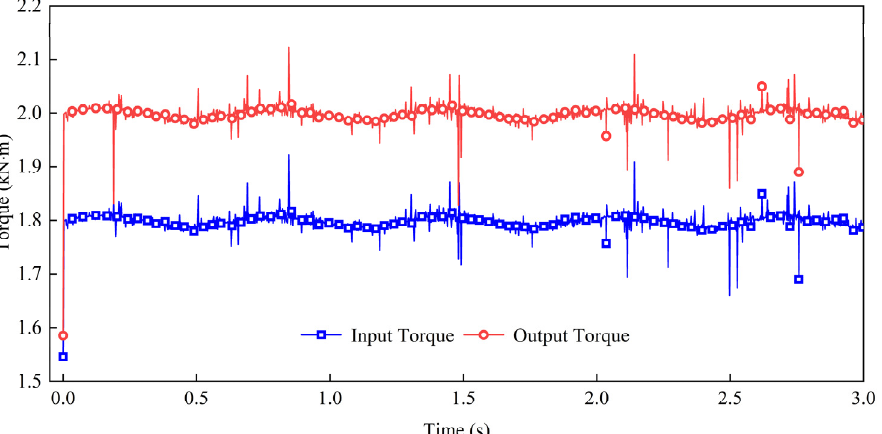
Figure 13. Output torque and input torque of flexible joint.